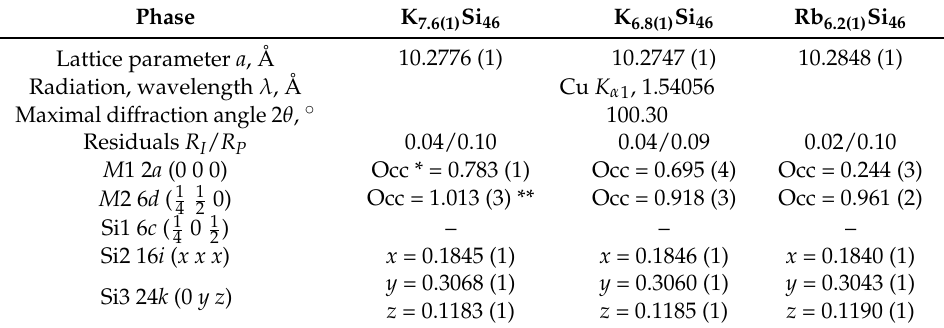
Table 2. Crystallographic information on the clathrate-I phases prepared by SPS (PXRD data).